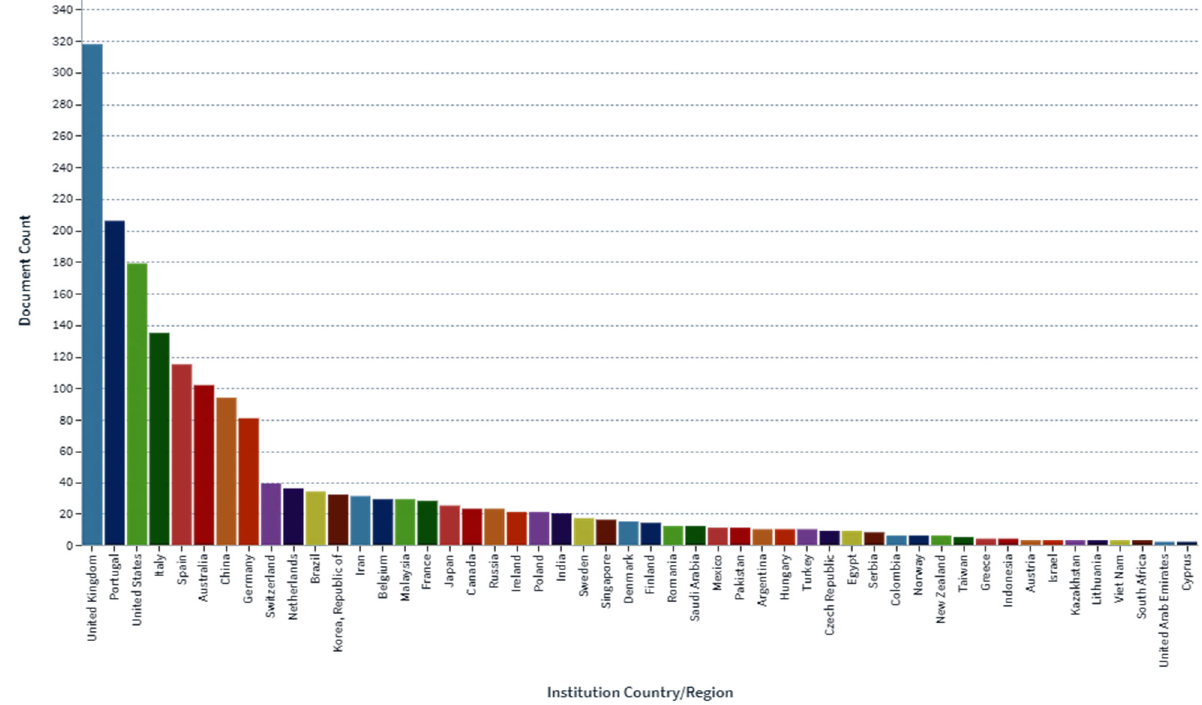
Figure 18. Number of papers published ( n = 88) according to the geographical location and country affiliation.